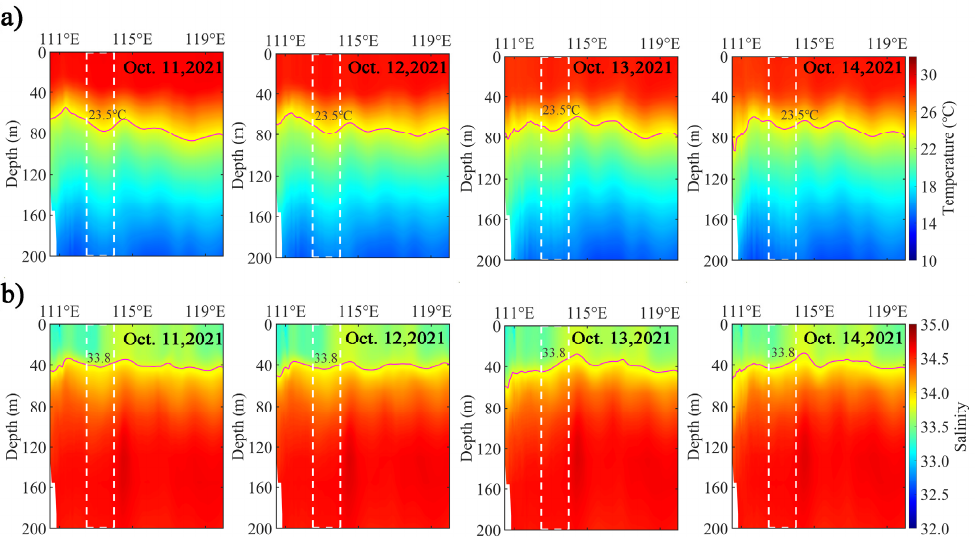
Figure 8. Vertical profile of ( a ) temperature and ( b ) salinity averaged along the latitude before and after the passage of STS “Conson”. Before the passing of STS (9–10 September 2021), after the pass- ing of STS (11–12 September 2021). Vertical profile of the white dotted line box was the black box A in Figure 1. The red lines represent ( a ) 23.5 °C isotherm and ( b ) 33.8 isohaline.